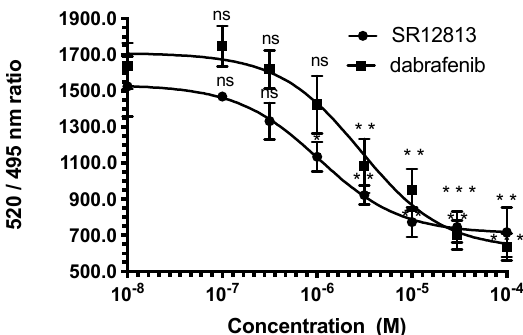
Figure 3. Dabrafenib binds to hPXR. Inhibition of FRET between fluorescein-labeled PXR ligand and recombinant GST-hPXR by SR12813 or dabrafenib. Results are expressed as the signal from the fluorescein emission divided by the terbium signal to provide a TR-FRET emission ratio. Data are the mean ( ± sd) from three independent experiments, *** p < 0.001, ** p < 0.01, * p < 0.1 (Student’s t -test) compared with DMSO-treated cells.3.3. Induction of hPXR-Mediated Proliferation by Dabrafenib.